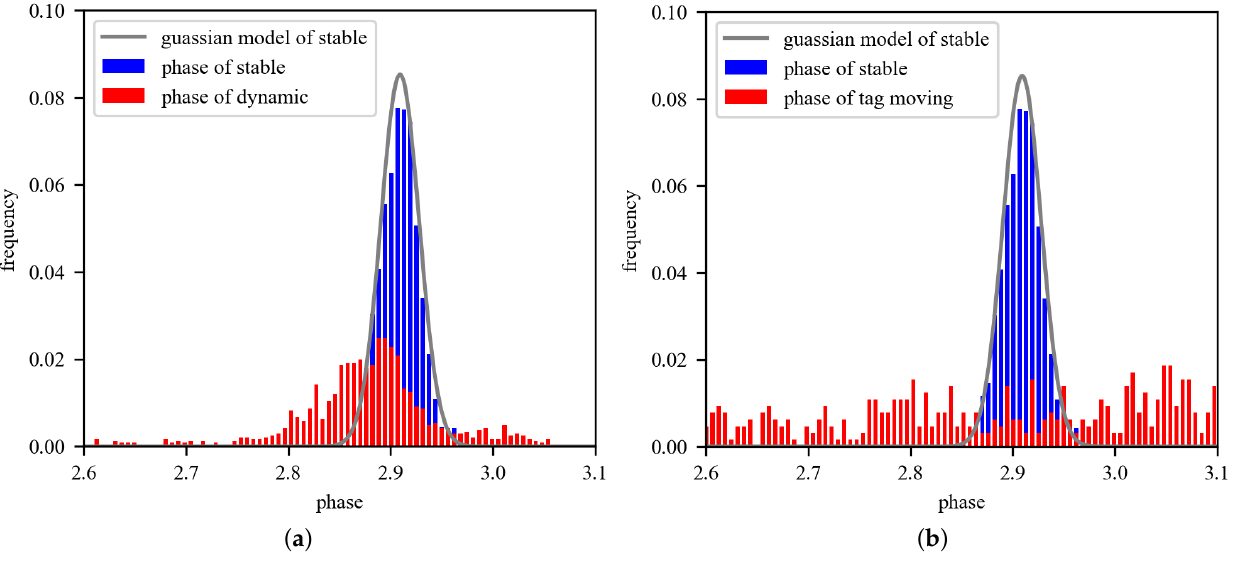
Figure 2. Gaussian distribution of RF phase in different scenarios. ( a ) Description of the change of phase distribution, when the environment becomes dynamic. ( b ) Description of the change of phase distribution, when the node is